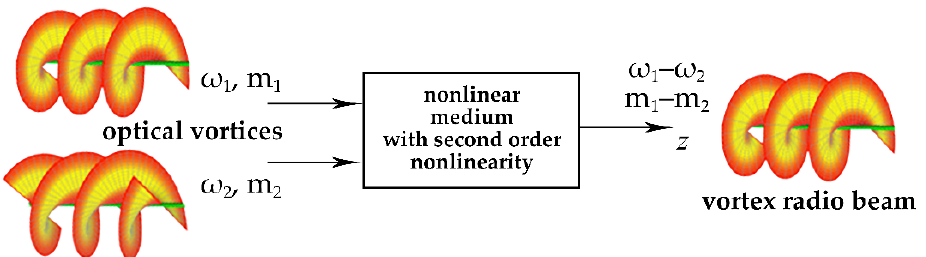
Figure 1. Simulated scheme for converting vortex beams: 1–opaque mirror, 2–semitransparent mirror; ω 1 , m 1 and ω 2 , m 2 are input frequencies and OAM orders, respectively.